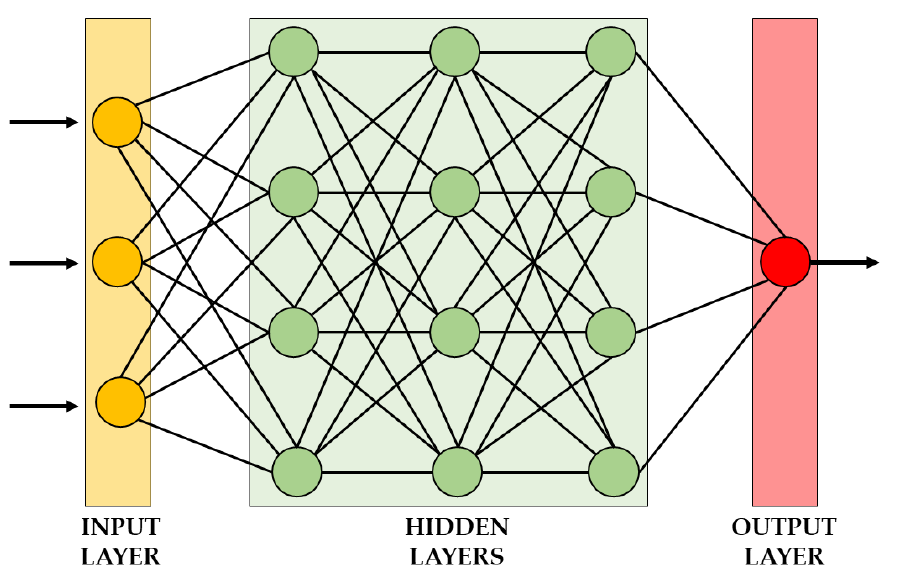
Figure 18. An artificial neural network.